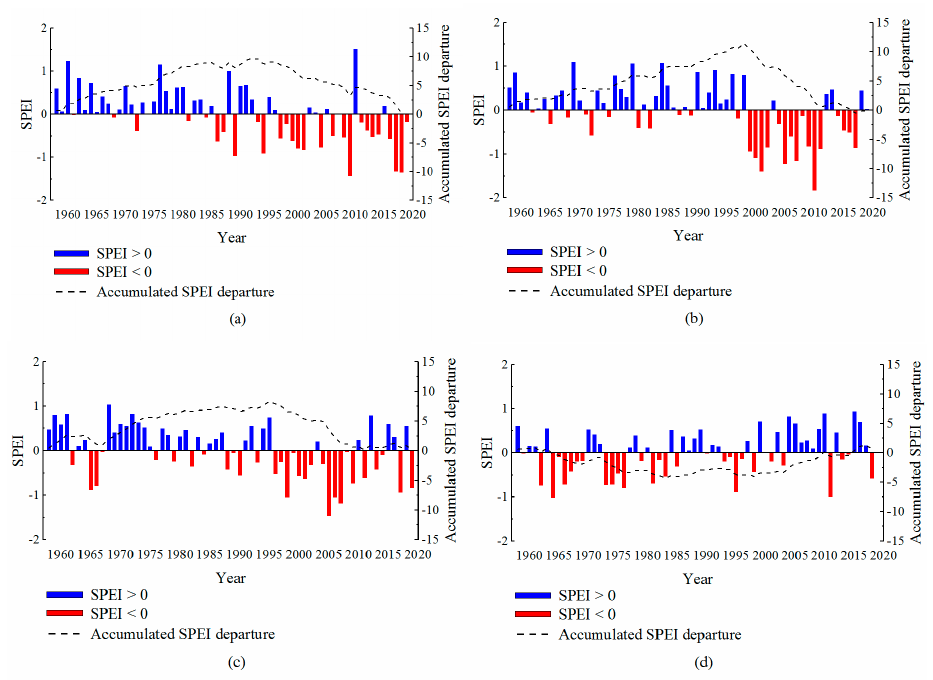
Figure 3. The changes of SPEI values in ( a ) spring, ( b ) summer, ( c ) autumn, and ( d ) winter, over the years.